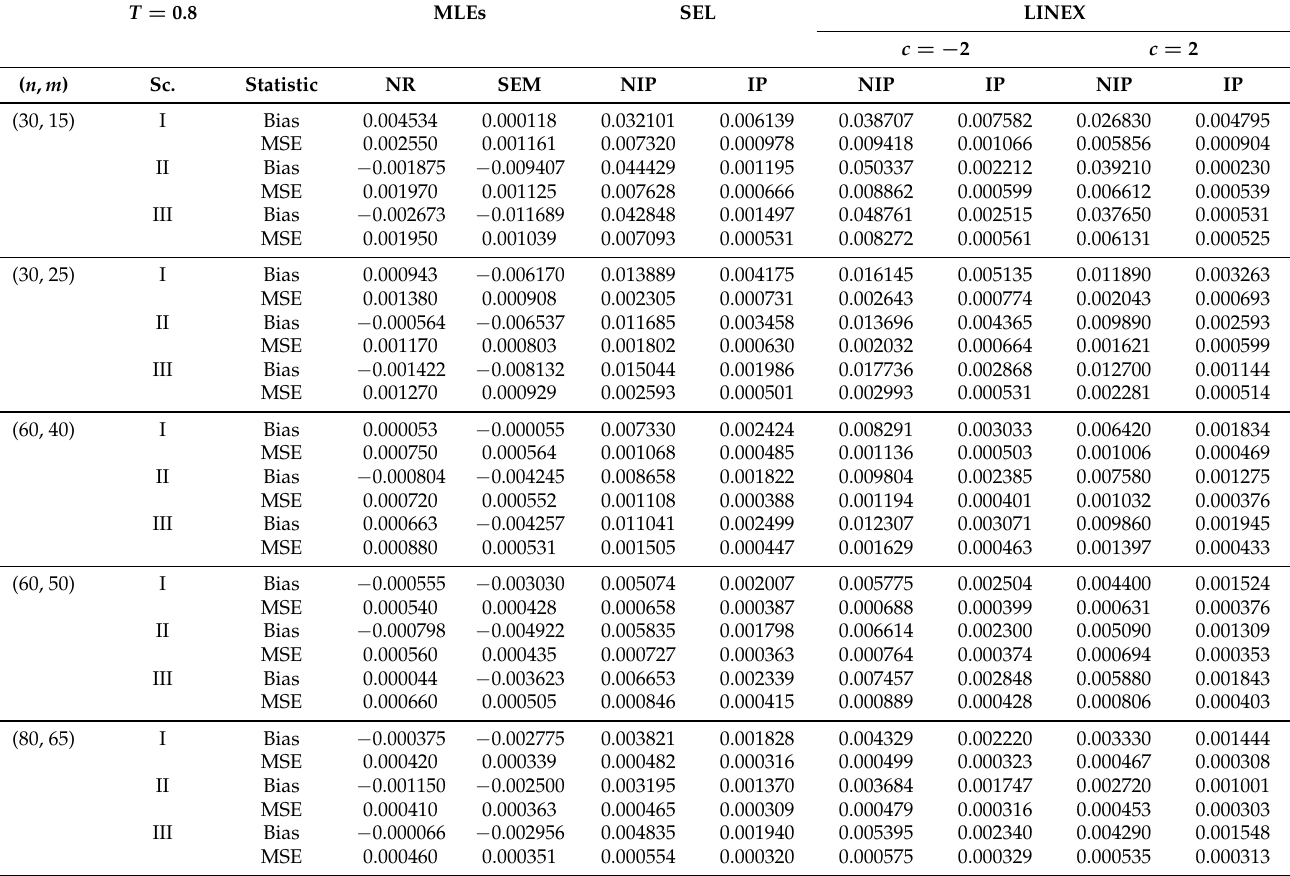
Table 9. Average values of the biases (first row) and MSEs (second row) for MLEs and Bayes estimators of θ 2 under informative prior (IP) and noninformative (NIP) prior and different censoring schemes, when ( θ 1 , θ 2 , λ ) = (0.05, 0.06,